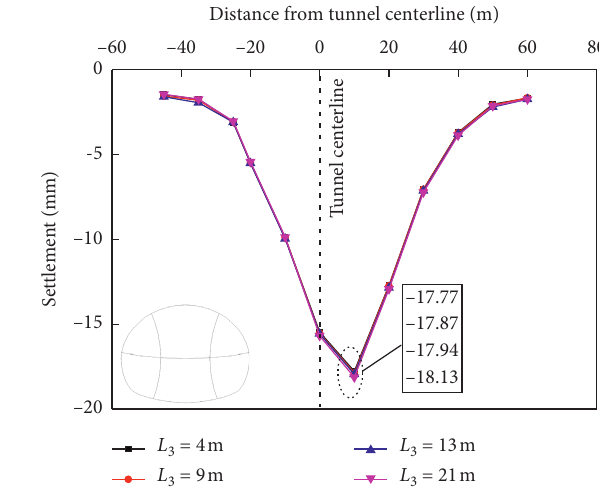
Figure 9: Distribution characteristics of maximum principal stress of caverns ① and ③ . (a) L and (e) L 2 � 21m.